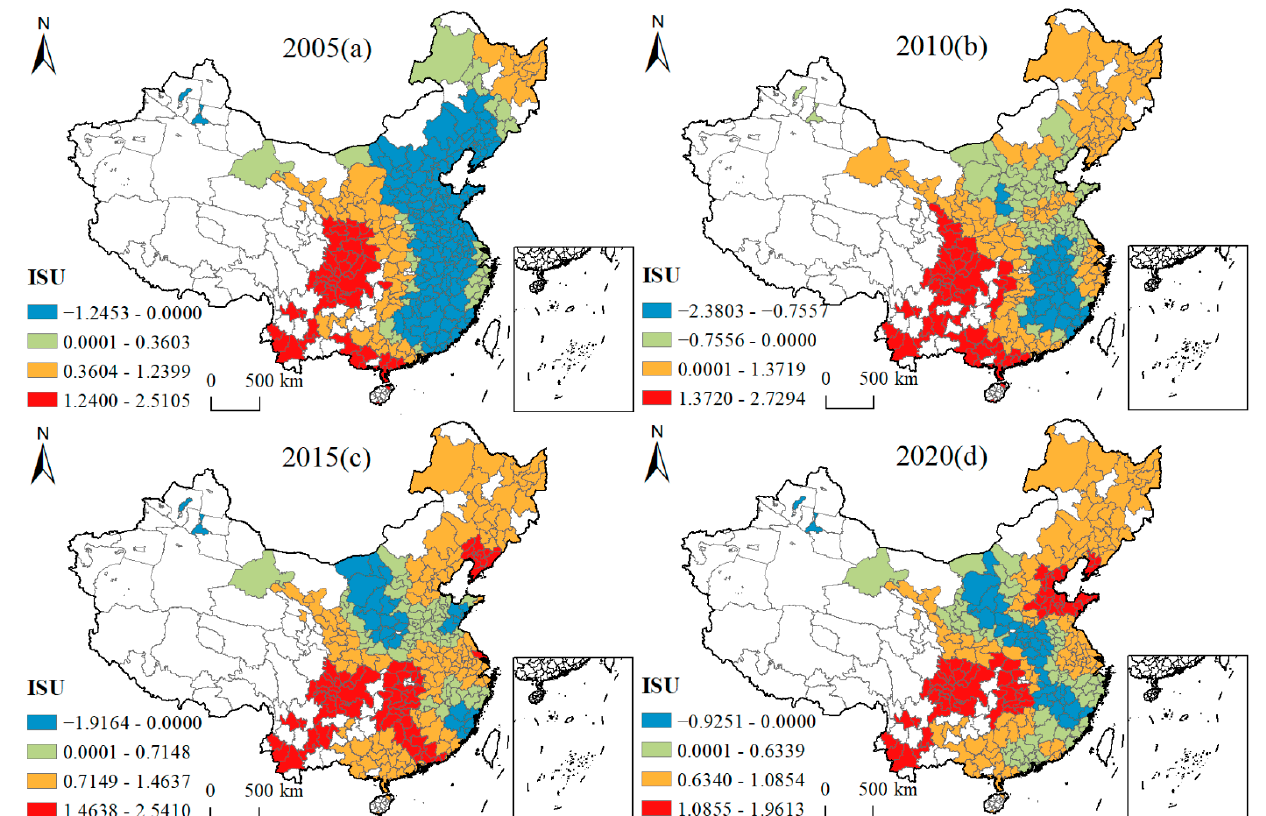
Figure 6. Four-year regression coefficients of ISU.